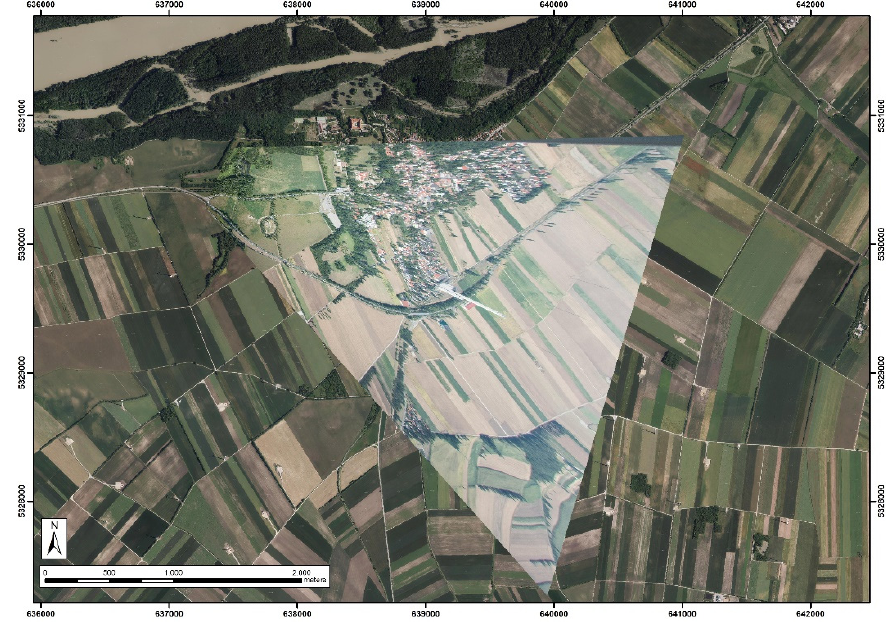
Figure 11. Carnuntum, Lower Austria. Transformation of a rather high-oblique photograph (pitch = 24°, but no horizon visible) based on its calculated footprint. Background data source: basemap.at [17].